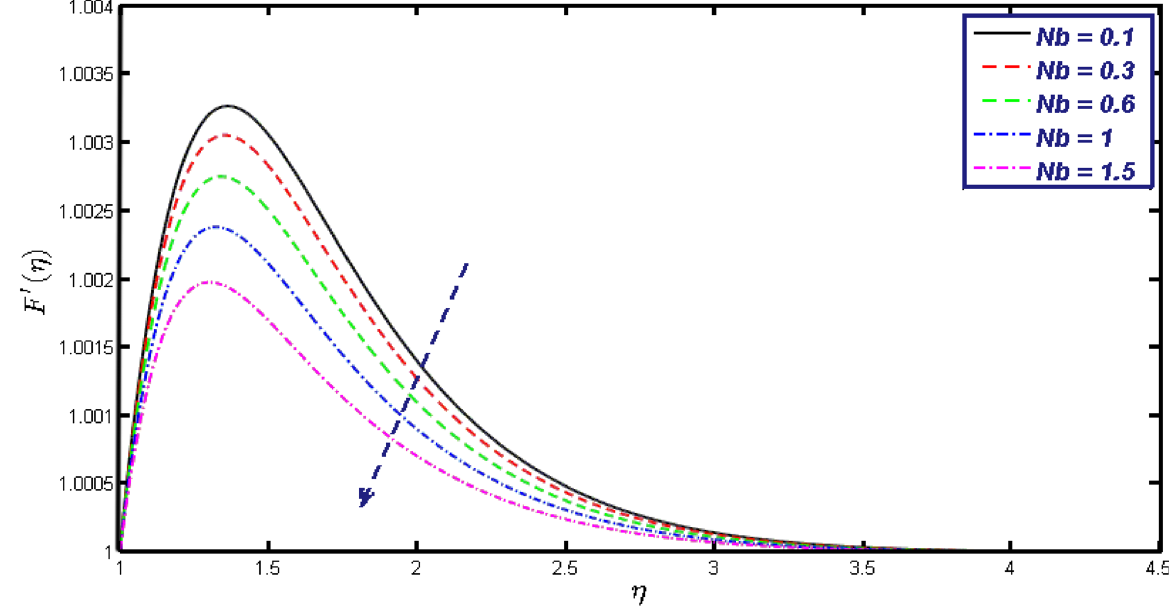
Figure 5. Velocity field for different values of Nb .